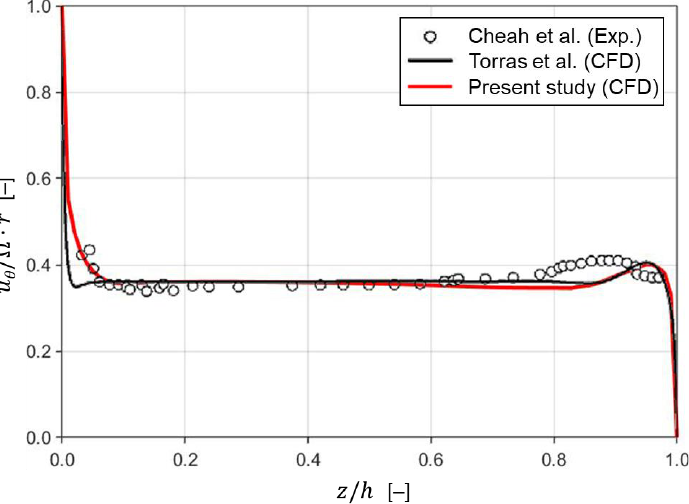
Figure 4. Comparison of the mean circumferential velocity ( 𝑢 θ ) profiles at 𝑟/𝑅 = 0.4 along the gap between the disk and the membrane surface when Re = 1.6 × 10 6 . The red line indicates the velocity profile obtained numerically in the present study. Both circles and the black line are velocity profiles in [31] (reprinted from Torras et al. [31] with permission from Elsevier). The original experimental data (circles) are from Cheah et al. [60].